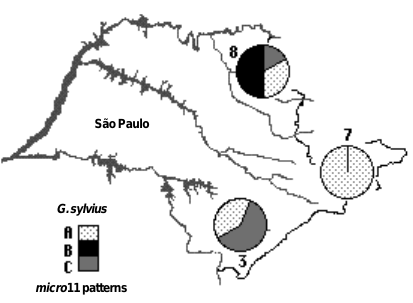
Figure 5 - Geographic distribution of micro 11 patterns (see Figure 4) of three Gymnotus sylvius populations.